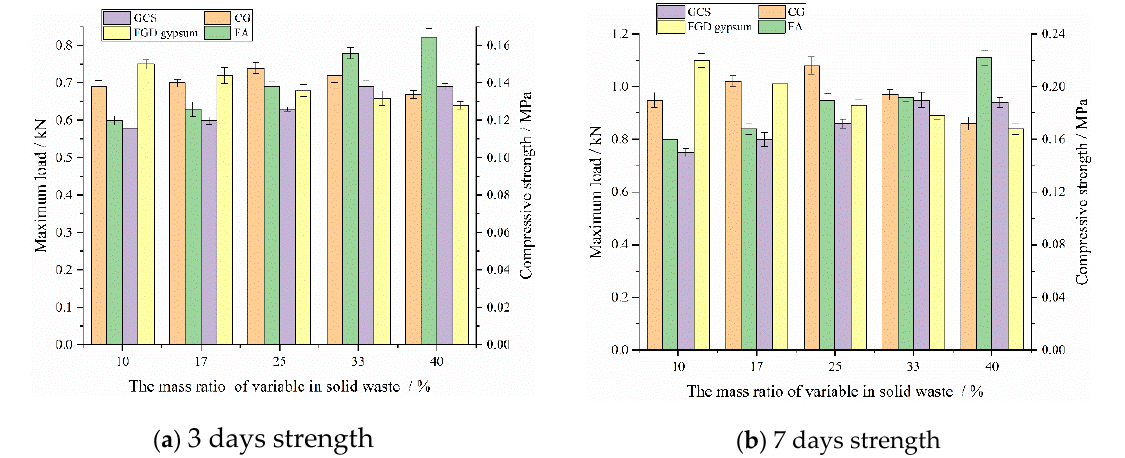
Figure 7. Relationship between different solid-waste proportions and early strength. It can be seen from Figure 7 that when the OPC content is 2%, the early strength maximum load in 3-day and 7-day are 0.83 kN and 1.11 kN, respectively, while the corre-